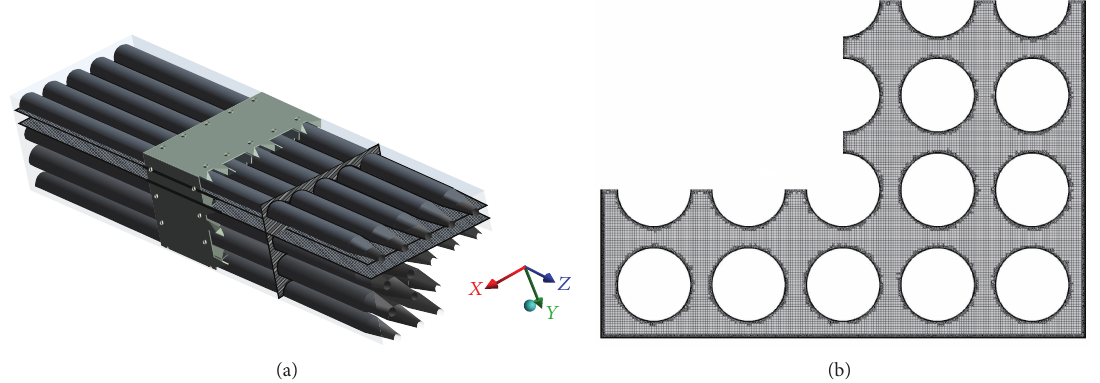
Figure 8: Planes selected across the model (a) and mesh distribution for the cross section plane (b).